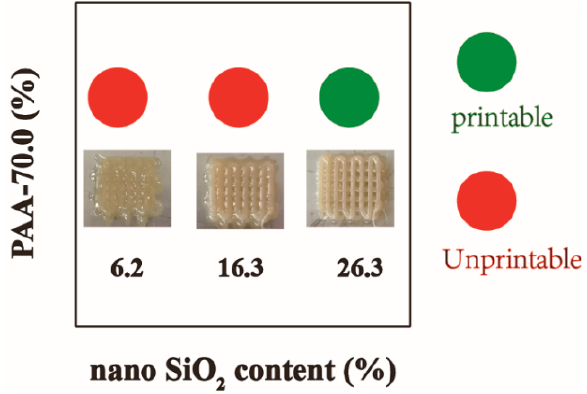
Figure 4. The printability of SiO 2 @PAA composite inks.